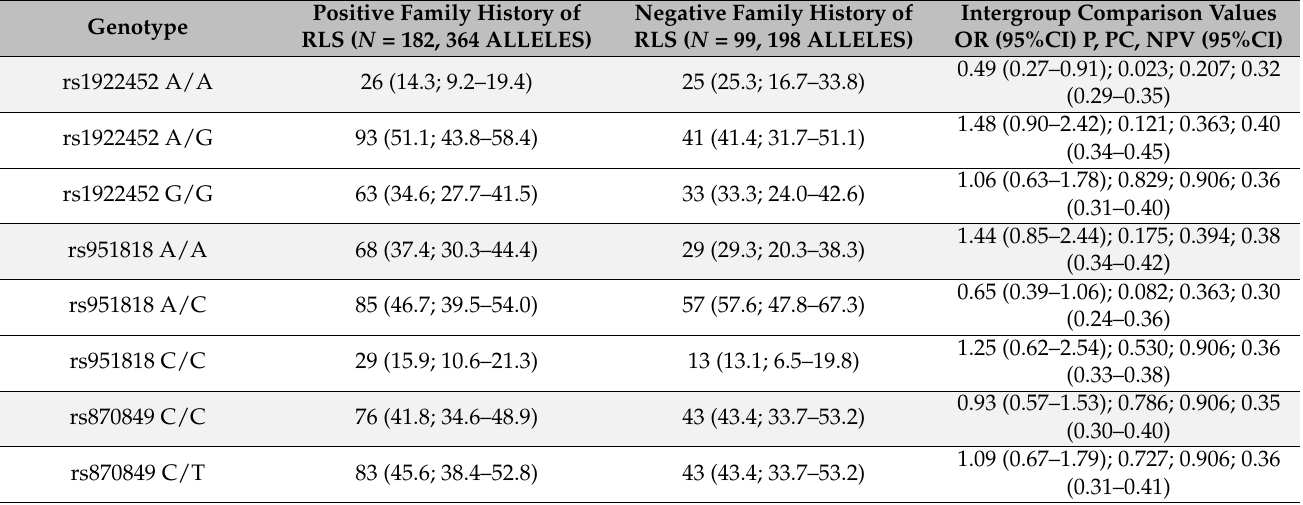
Table 2. Genotypes and allelic variants of patients with RLS distributed by family history. The values in each cell represent the number (percentage; 95% confidence